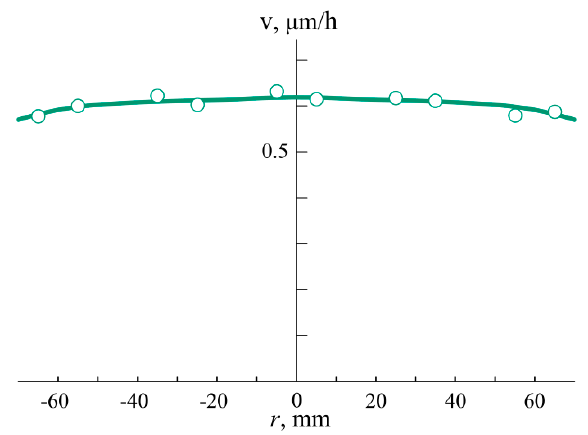
Figure 4. Substrate etching rate v versus the distance r from the center of the flange.